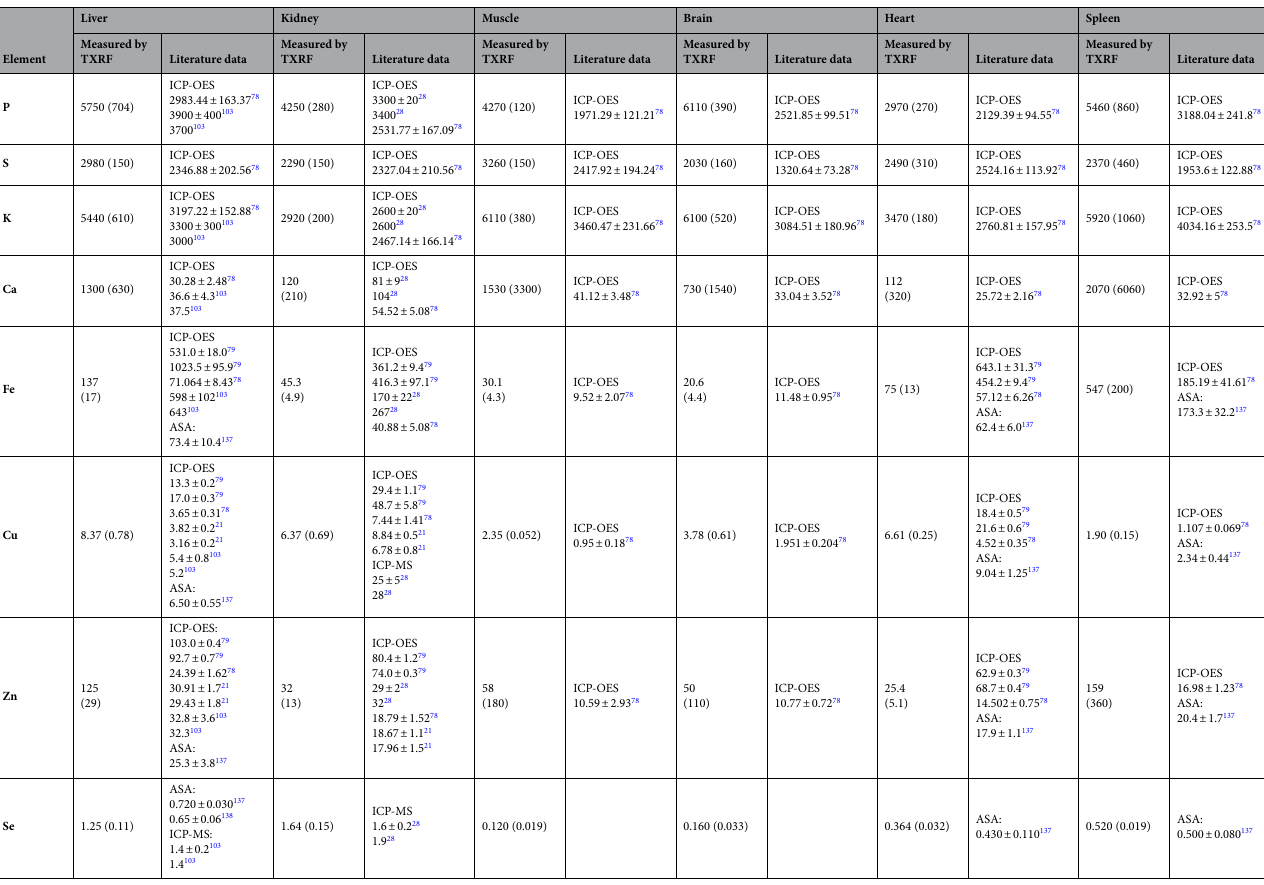
Table 5. The median value [μg/g] of P, S, K, Ca, Fe, Cu, Zn and Se concentrations obtained for each organ using TXRF together with corresponding literature data. In the parentheses the interquartile range of the concentration value is shown.